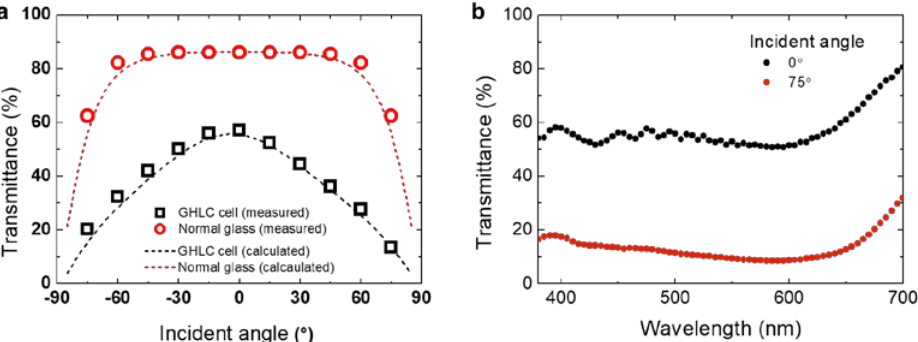
Figure 4. ( a ) Measured (circles and squares) and calculated (dash lines) transmittance of a GHLC cell and regular glass vs. the incident angle. ( b ) Measured transmission spectra of a GHLC cell under normal and oblique incidences.